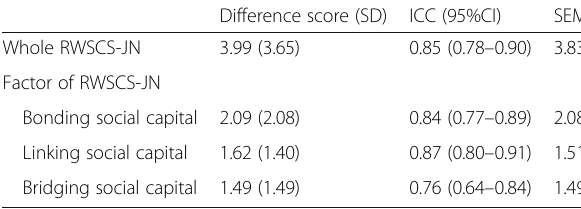
Table 4 Test-retest reliability of the RWSCS-JN